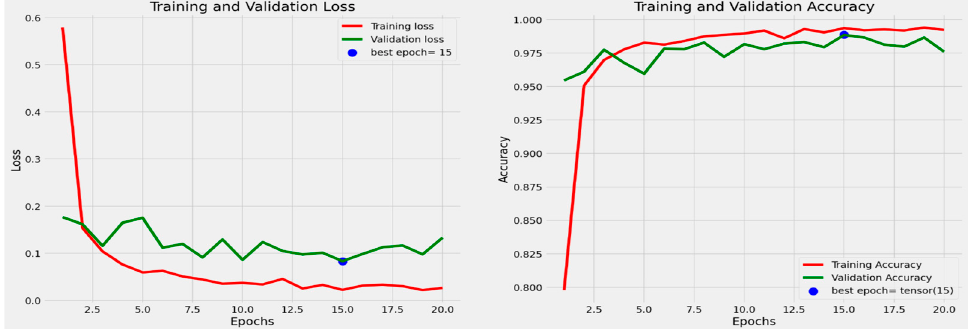
Figure 7. Training and validation loss and Accuracy for game ship classification dataset.